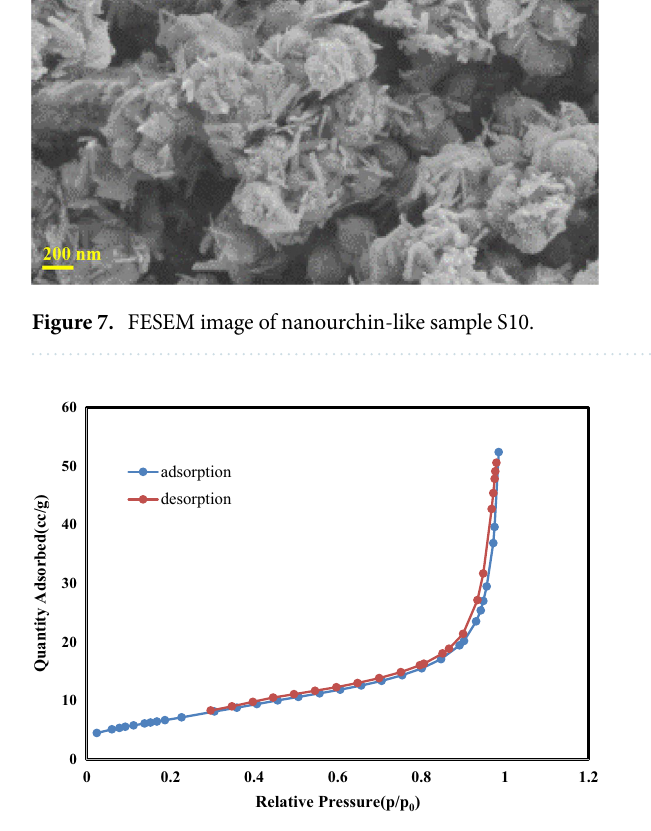
Figure 8. Nitrogen adsorption–desorption isotherms of S3.